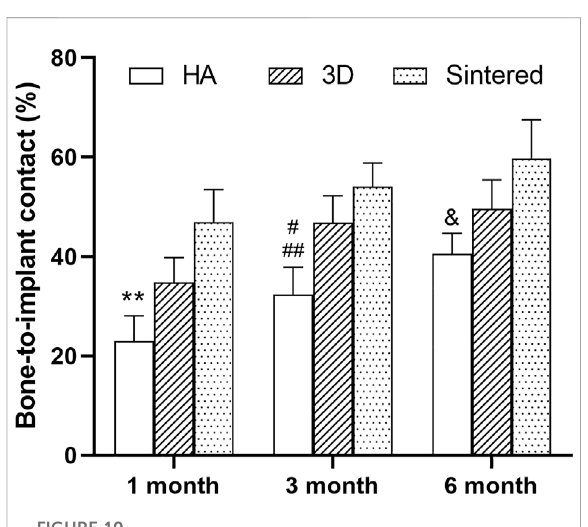
FIGURE 10 BIC values of three materials over time. **, comparison of HA and sintered porous titanium at 1 month, p < 0.01; # , comparison of HA group and 3D porous titanium group at 3 months, p < 0.05; ## , comparison of HA group and sintered porous titanium group at 3 months, p < 0.01; &, comparison of HA group and sintered porous titanium group at 6 months, p <